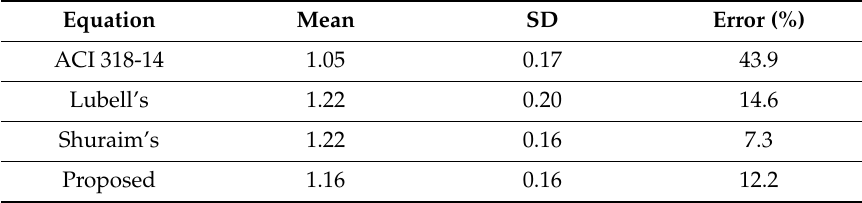
Table 7. Comparison of shear equation’s